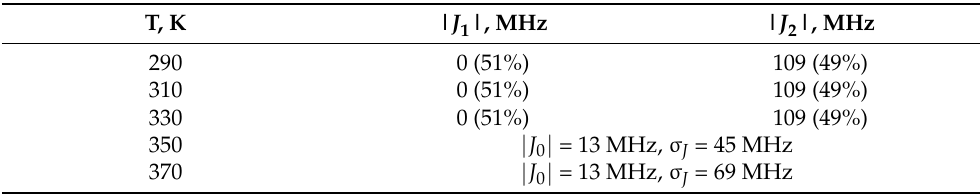
Table 2. Parameters corresponding to the best fit of the EPR spectra of biradical 4 in a toluene solution at different temperatures. T, K | J 1 |, MHz | J 2 |, MHz 290 0 (51%)